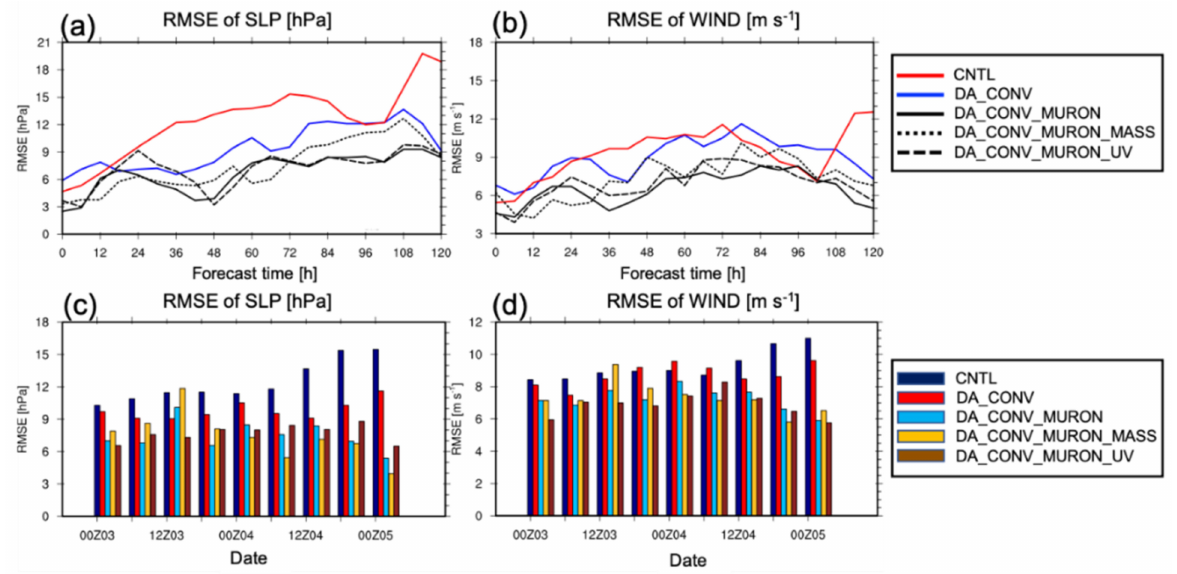
Figure 6. The RMSEs of ( a ) MSLP and ( b ) maximum surface wind speed forecast for the control run (solid red line), the DA_CONV (solid blue line), the DA_CONV_MURON (solid black line), DA_CONV_MURON_MASS (dotted black line), and the DA_CONV_MURON_WIND (dashed black line) averaged over all DA cycles. The RMSEs of ( c ) MSLP and ( d ) maximum surface wind speed forecast for the control run (navy bars), the DA_CONV (red bars), the DA_CONV_MURON (blue bars), the DA_CONV_MURON_MASS (yellow bars), and DA_CONV_MURON_WIND (brown bars) for each cycle from 0000 UTC 3 November to 0000 UTC 5 November